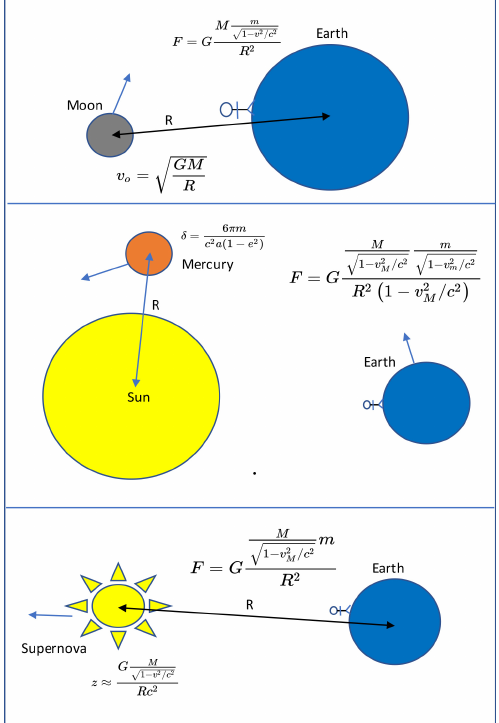
Figure 1. The figure shows two different situations and how they affect which masses (also in gravity) should be seen as relativistic and which mass is a rest mass. This depiction follows standard logic from relativity